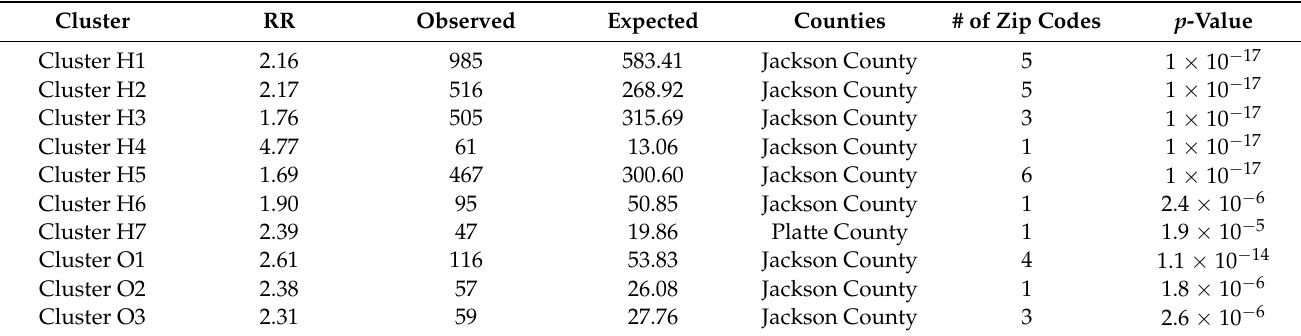
Table 6. Spatial clusters of COVID-19 with respect to Hispanic (H) and Other (O) populations (i.e., Asian, American Indian, and Hawaiian and Pacific Islander).